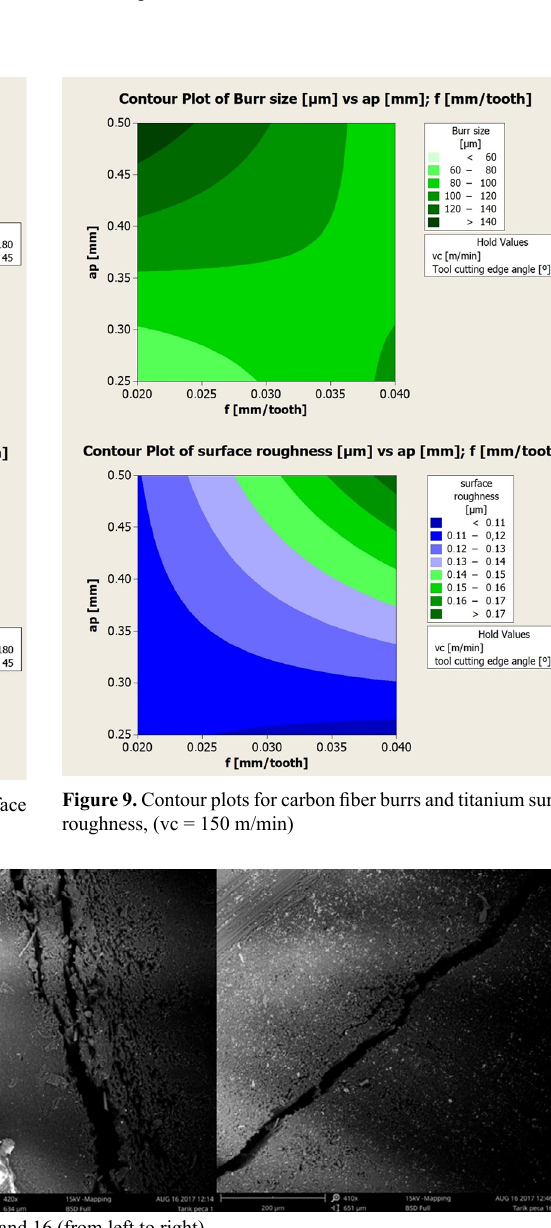
Figure 10. Occurrence of delamination on sample pieces 1, 8 and 16 (from left to right)